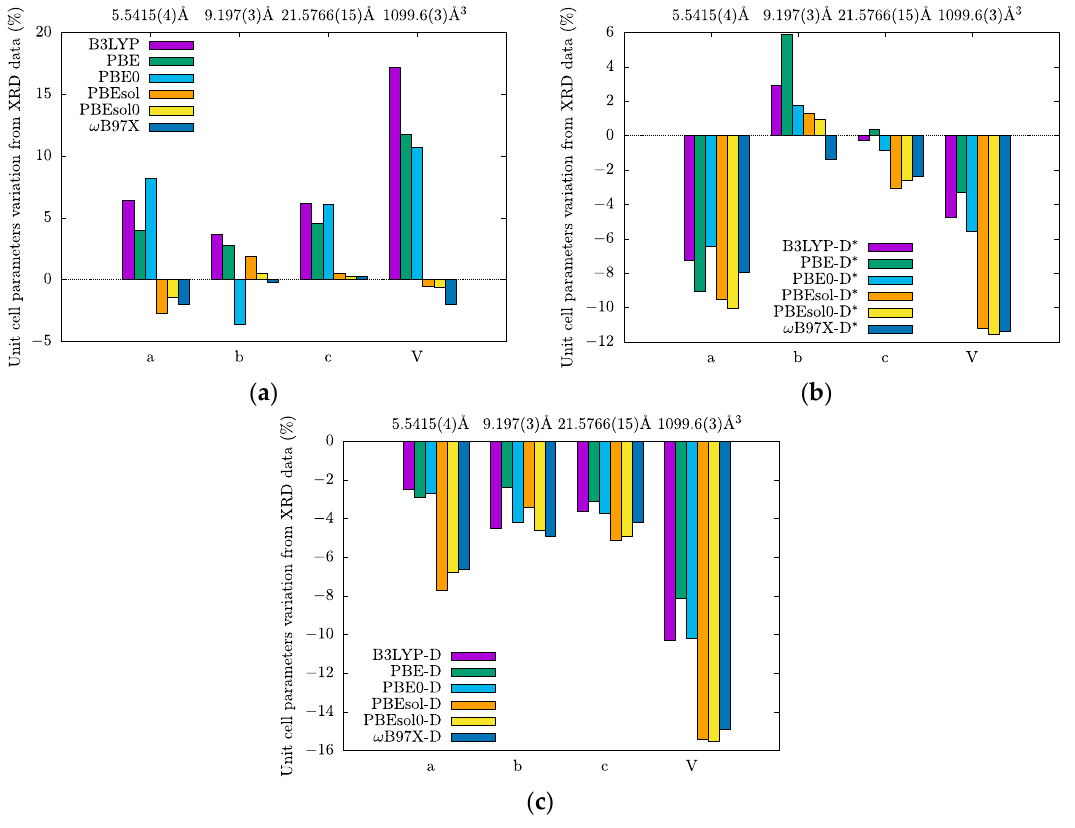
Figure 2. Differences (in %) between the optimized unit cell parameters and the XRD values as a function of the XCF, Δ = [X(Calc.) − X(XRD)]/X(XRD): ( a ) with DFT; ( b ) with DFT-D*; ( c ) with DFT-D2. The XRD values are given on the top of each figure. The 6-31G(d,p) basis set was used for all calculations.